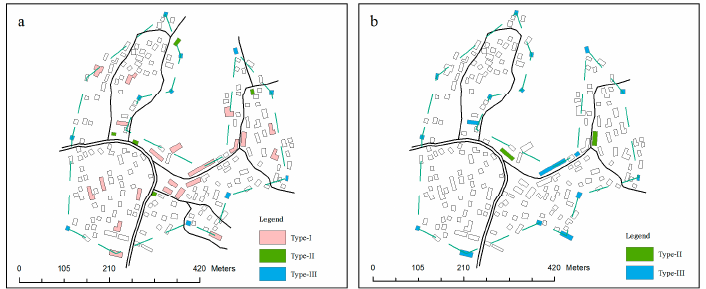
Figure 23. Must-be-selected buildings in selection unit B when the target scale is: ( a ) 1:25,000, and ( b ) 1:50,000. The green dashed line is the simplified boundary line.